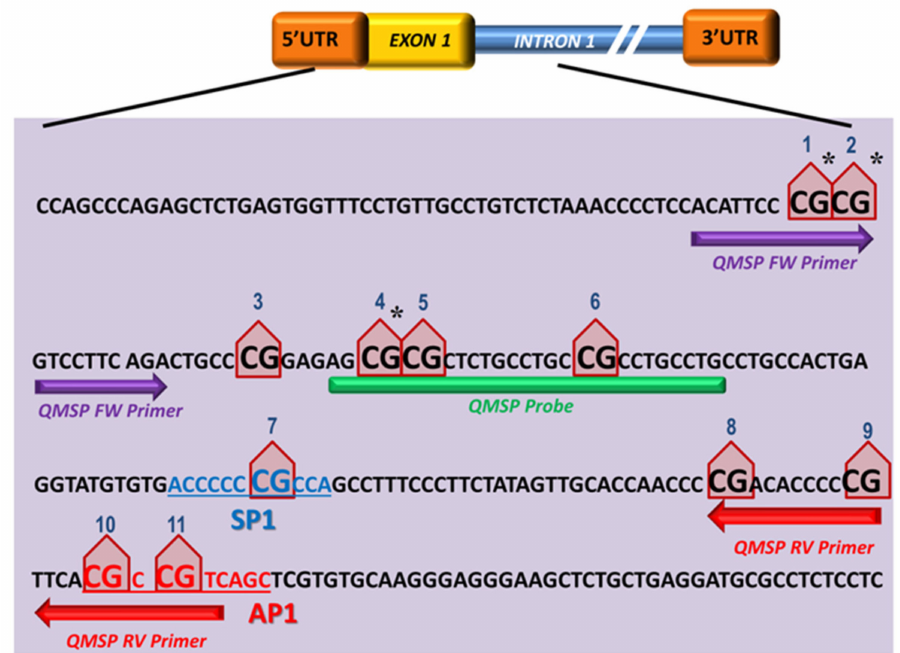
Figure 1. Sequence of SPARC promoter region ( − 29 bp to + 191 bp) located spanning from exon 1 to intron 1 of the gene. Eleven CpGs are marked as red triangle shape and numbers are given from 5 (cid:48) to 3 (cid:48) of positive strand of the SPARC gene. The QMSP amplified region counts 111 bp (Forward in purple arrow, Probe in green segment and Reverse in red arrow). The letters colored and underlined indicate SP1 (blue) and AP1 (red) binding consensus sequences, respectively. * indicates the CpGs included in the 450 K